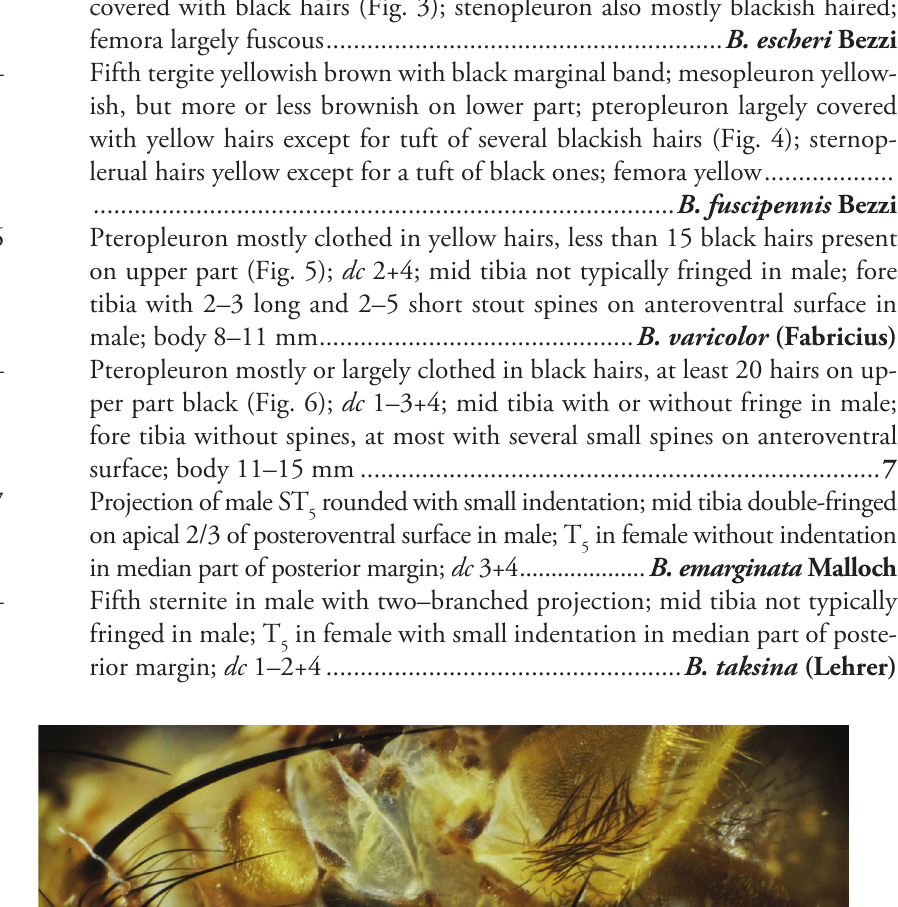
lerual hairs yellow except for a tuft of black ones; femora yellow ................... Pteropleuron mostly clothed in yellow hairs, less than 15 black hairs present on upper part (Fig. 5); dc 2+4; mid tibia not typically fringed in male; fore tibia with 2–3 long and 2–5 short stout spines on anteroventral surface in